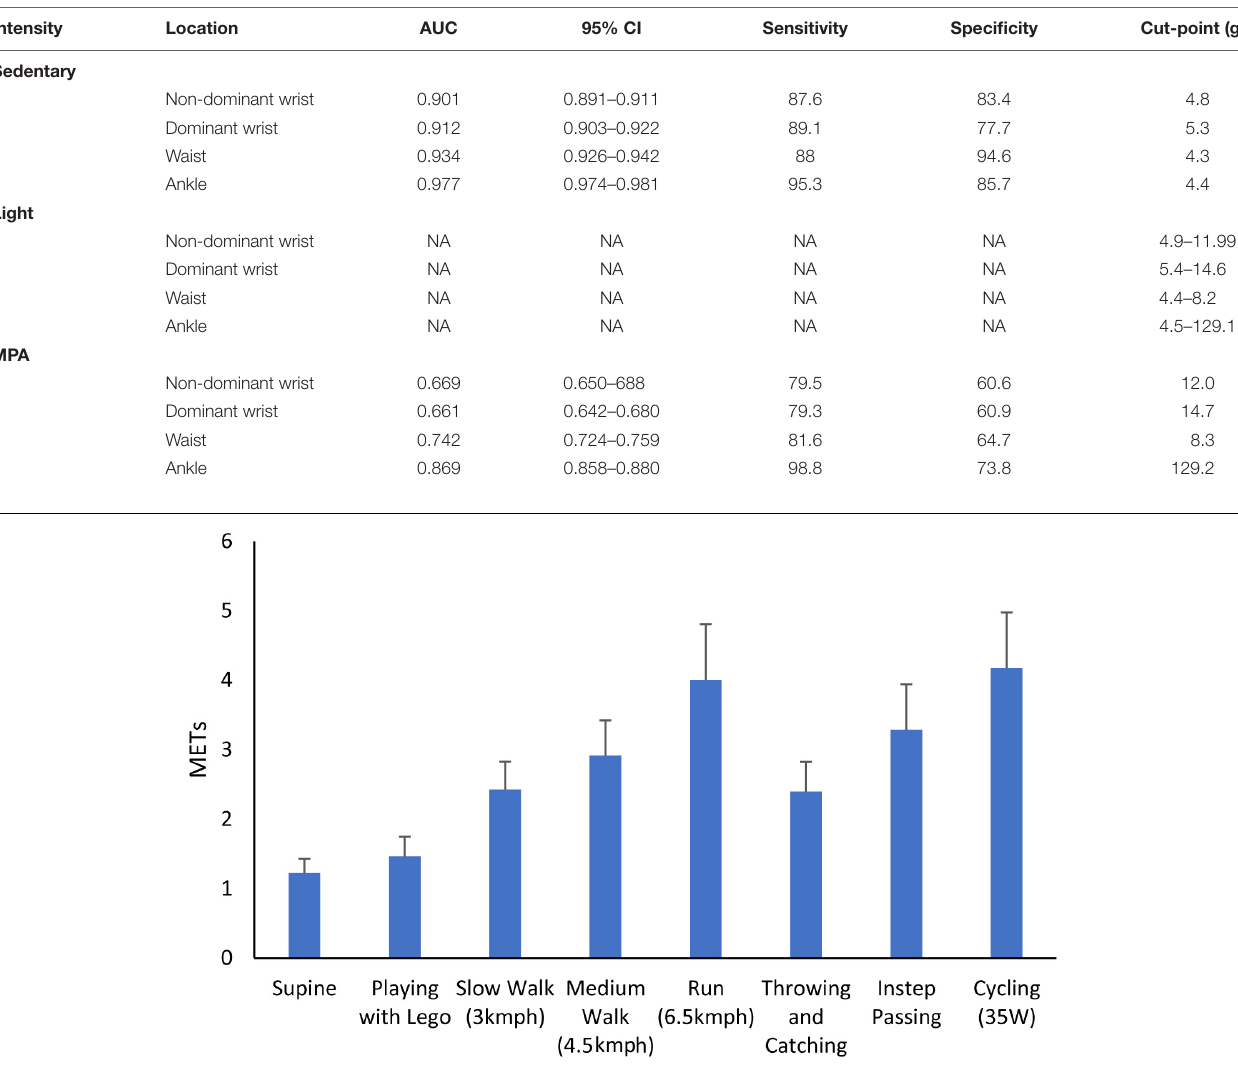
TABLE 2 | Sensitivity, specificity and area under the curve and resultant cut-points for each GENEA monitor. Intensity Location AUC 95% CI Sensitivity Specificity Cut-point (gs)